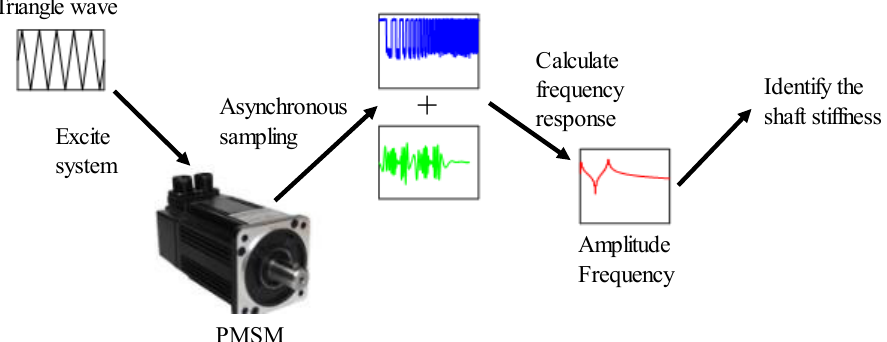
Figure 4. Identification method flowchart.